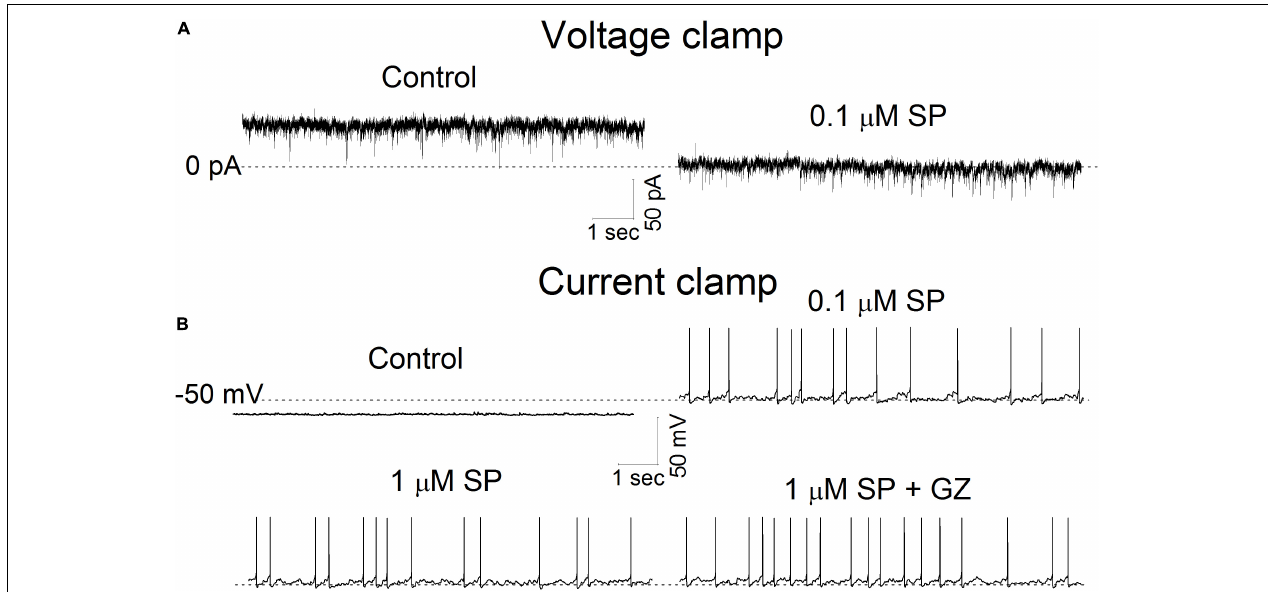
FIGURE 9 | The effect of SP on holding current and membrane potential. (A) Current traces were recorded in voltage-clamp mode before and during application of 0.1 µ M SP at a holding potential of -50 mV. The dotted line represents 0 pA. (B) . Membrane potential traces were recorded before and during a 5 min application of